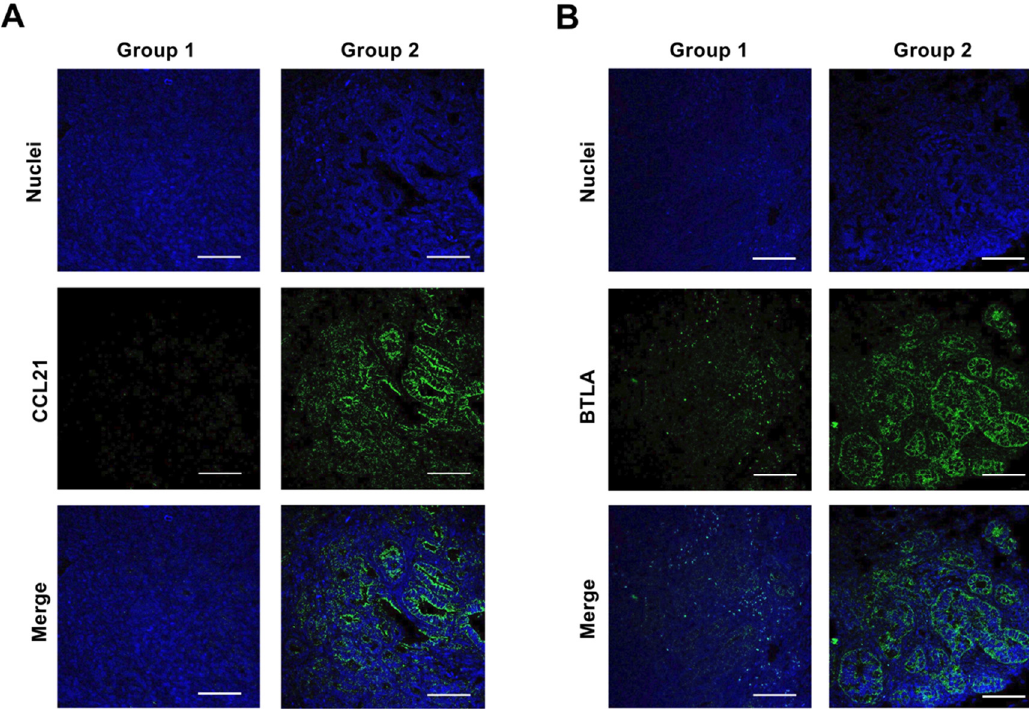
Figure 7. CCL21 and BTLA protein expression in tumor tissues in pancreatic cancer model mice with or without fucoxanthin (Fx) administration. Green fluorescence indicates CCL21 and BTLA. Blue fluorescence indicates nuclei. Confocal images of ( A ) CCL21 and ( B ) BTLA on tumor tissues in pancreatic cancer model mice. White bars are 100 μ m.